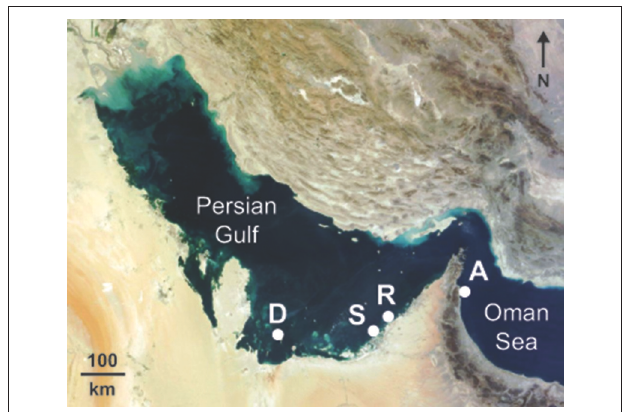
FIGURE 1 | Location of study sites where growth parameters were measured in the corals Platygyra daedalea and Cyphastrea microphthalma . Delma (D: 24.5208 ◦ N, 52.2781 ◦ E), Saadiyat (S: 24.5986 ◦ N, 54.4201 ◦ E), Ras Ghanada (R: 24.8482 ◦ N, 54.6903 ◦ E), and Al Aqah (A: 25.4929 ◦ N, 56.3635 ◦ E). Background NASA satellite image sourced from https://zoom.earth.